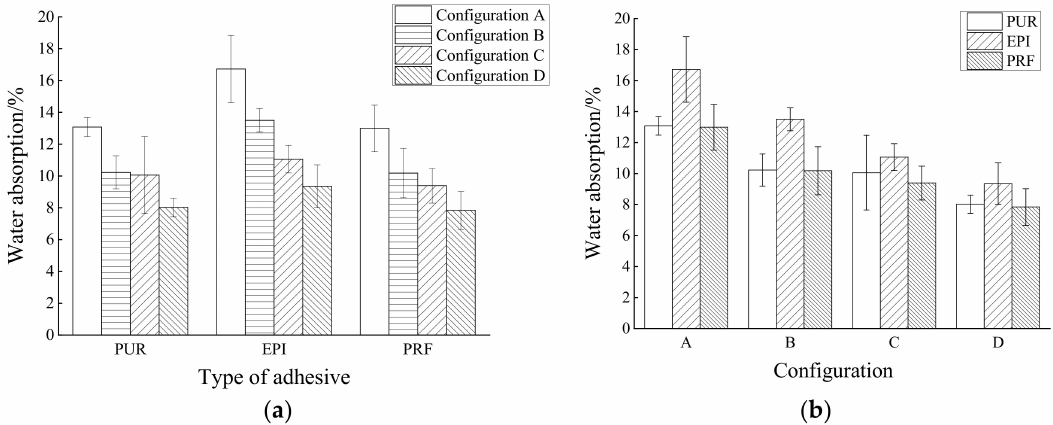
Figure 2. WA of CLT and HCLT specimens: ( a ) Influence of configuration, and ( b ) Influence of